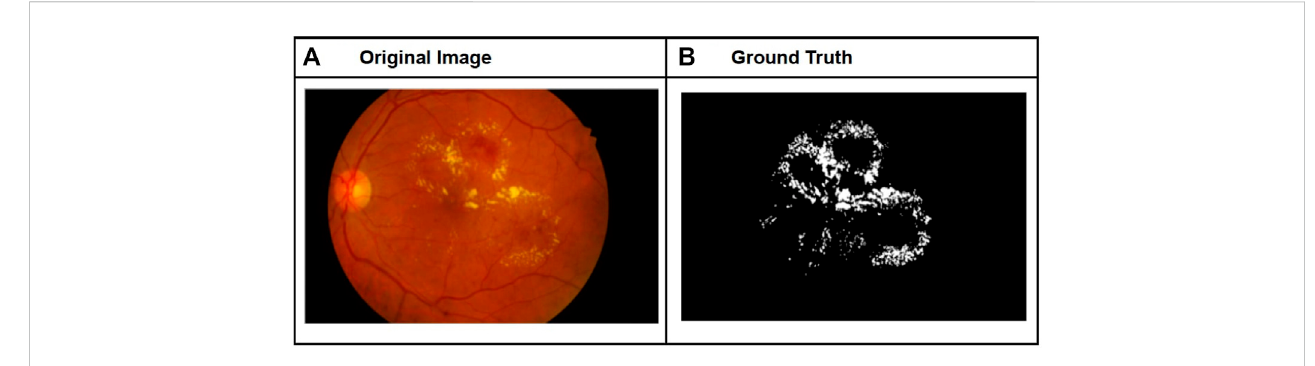
FIGURE 2 Sample fundal image with exudates (A) and corresponding ground-truth image for exudates (B) .